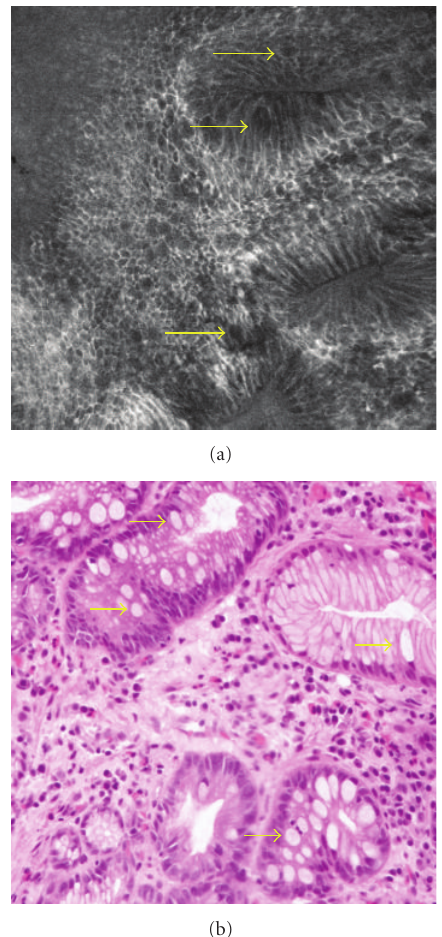
Figure 4: CLE image and histologic aspect (trasversal section) of the untreated esophageal zone: columnar lined epithelium with presence of focal mucin goblet cells (arrows), pathognomonic of gastric type mucosae with focal intestinal